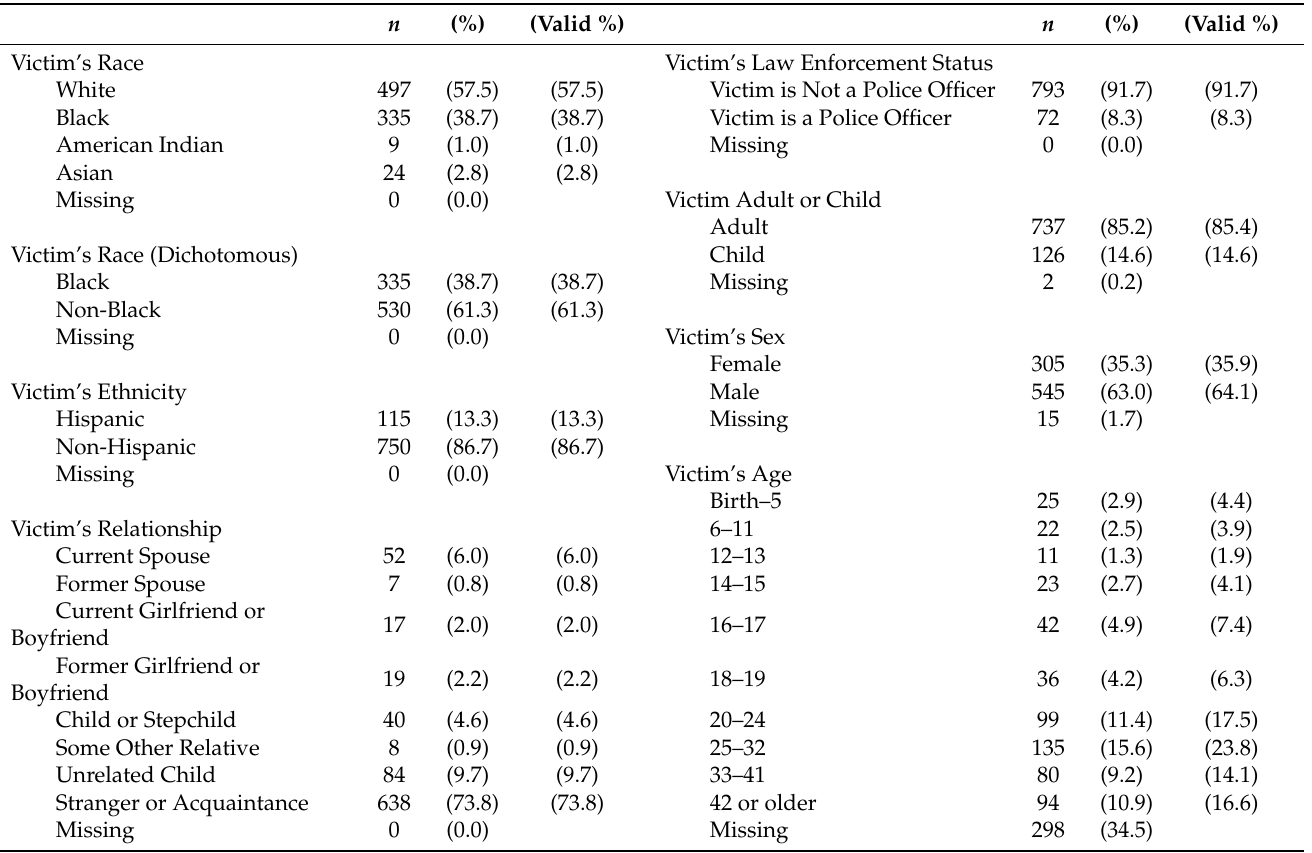
Table 2. Victim characteristics in police crime arrest cases, 2005–2014 ( N =